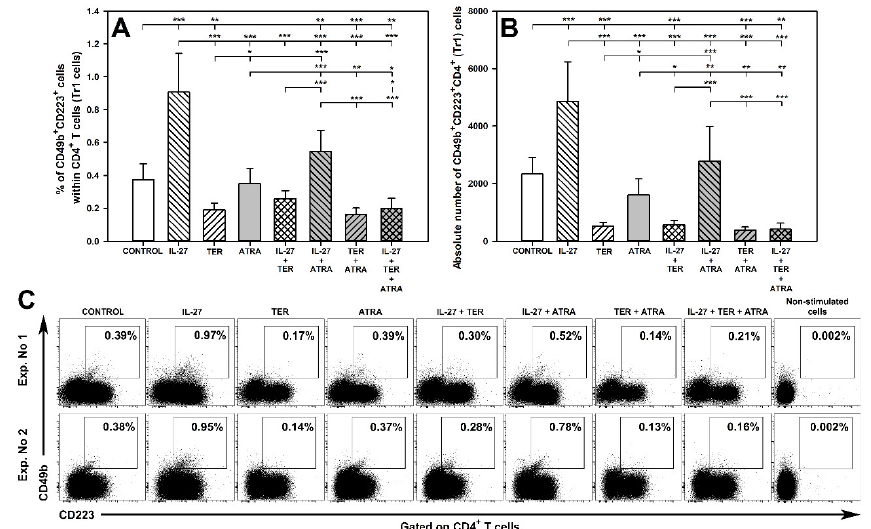
Figure 9. Effect of IL-27, teriflunomide (TER), all-trans-retinoic acid (ATRA), and their combinations on the number of CD49b + CD223 + CD4 + T cells, i.e., type 1 regulatory T (Tr1) cells. The relative ( A ) and absolute count ( B ) of these cells were determined in cell cultures incubated in the absence (CONTROL) and presence of IL-27 (100 ng/mL), TER (10 −4 M), and ATRA (10 −6 M) for 72 h including concomitant stimulation with IL-2, anti-CD3, and anti-CD28 and re-stimulation with PMA and iono- mycin for the last 5 h before harvest. Unstimulated cells served as a negative control for the cell activation. The relative count is expressed as a percentage of CD49b + CD223 + cells within CD4 + T cell subset ( A ). The absolute count represents the number of CD49b + CD223 + CD4 + T cells per sample well ( B ). Results are expressed as the mean (± S.D.) of three independent experiments with four mice per experiment (overall n = 12, * p < 0.05, ** p < 0.01, *** p < 0.001). Examples of dot plot cytograms for all treatments show the distribution of CD49b + CD223 + cells within CD4 + T cell subset ( C ).